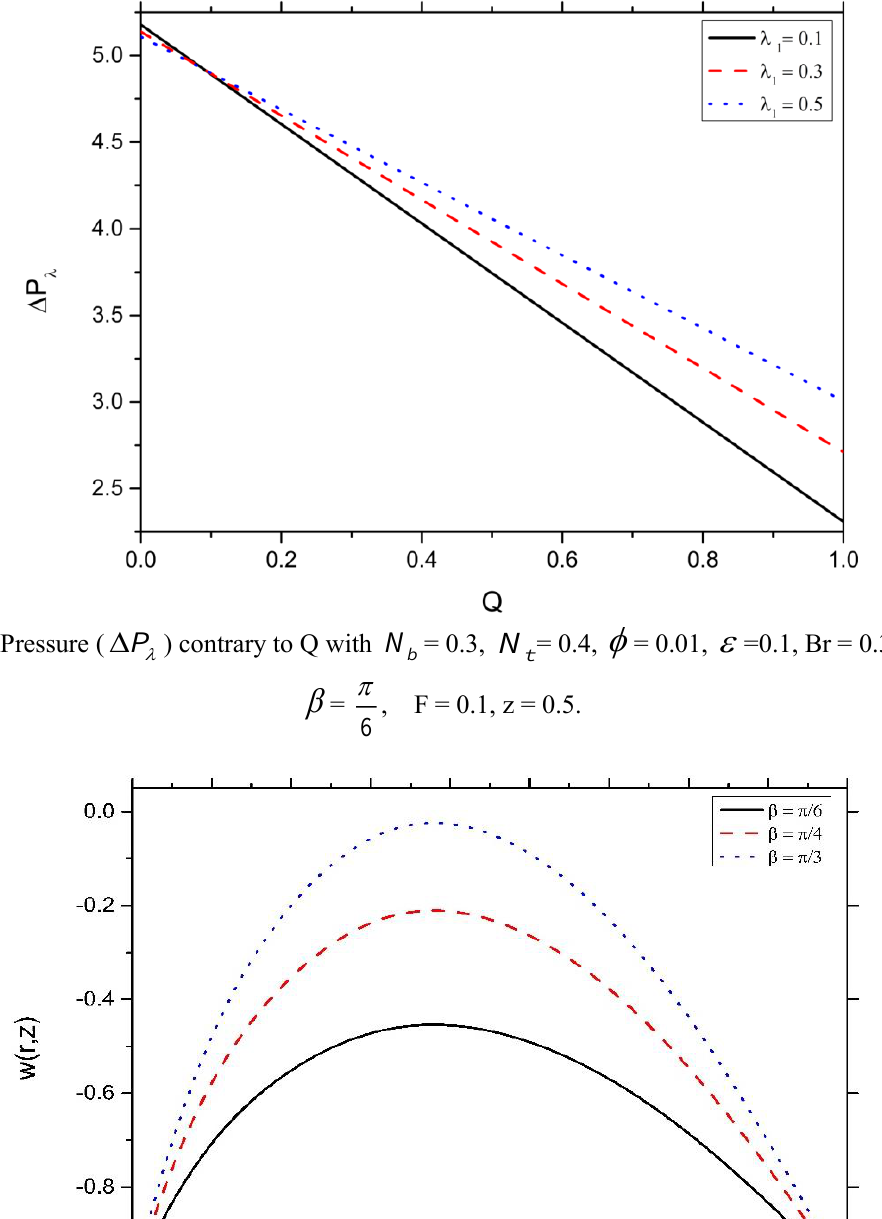
dp N = 0.4, z = 0.5, = 0.4, b dz  = 0.01, F = Br = 0.3, 1